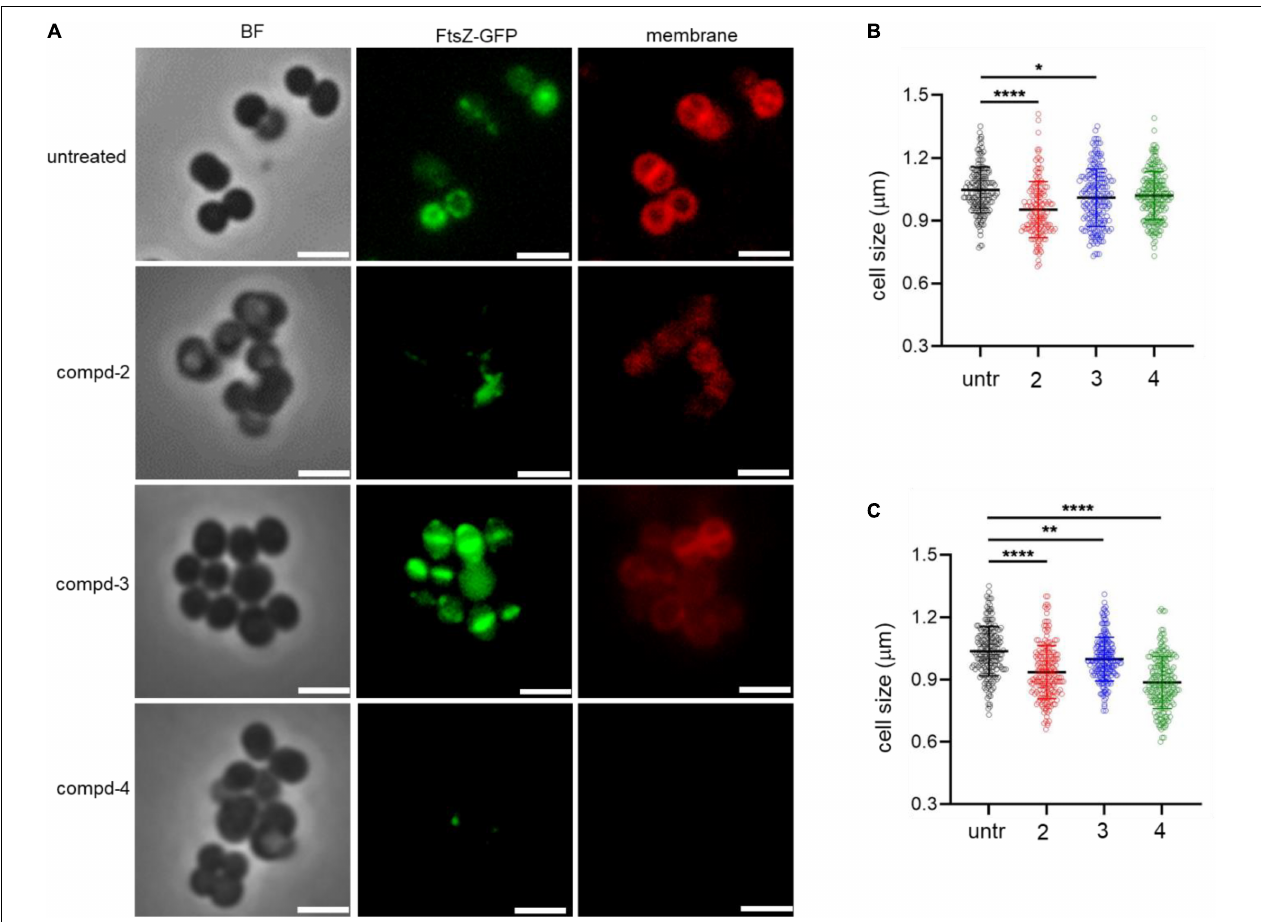
FIGURE 4 | Compounds 2 and 4 inhibit the bacterial septal formation. (A) USA300/pLow-ftsZ-GFP were treated with 20 µ g/mL of compounds and incubated at 37 ◦ C for 1 h. The cell membrane was stained using FMTM 4-64 Dye for 10 min. (B,C) Quantitative analysis of the cell size was performed at 5 µ g/mL (B) and 20 µ g/mL (C) . Scale bar = 2 µ m. Microscopy images are representative of at least three experiments. Statistically significant differences were defined as * P ≤ 0.05; ** P ≤ 0.01; and **** P ≤